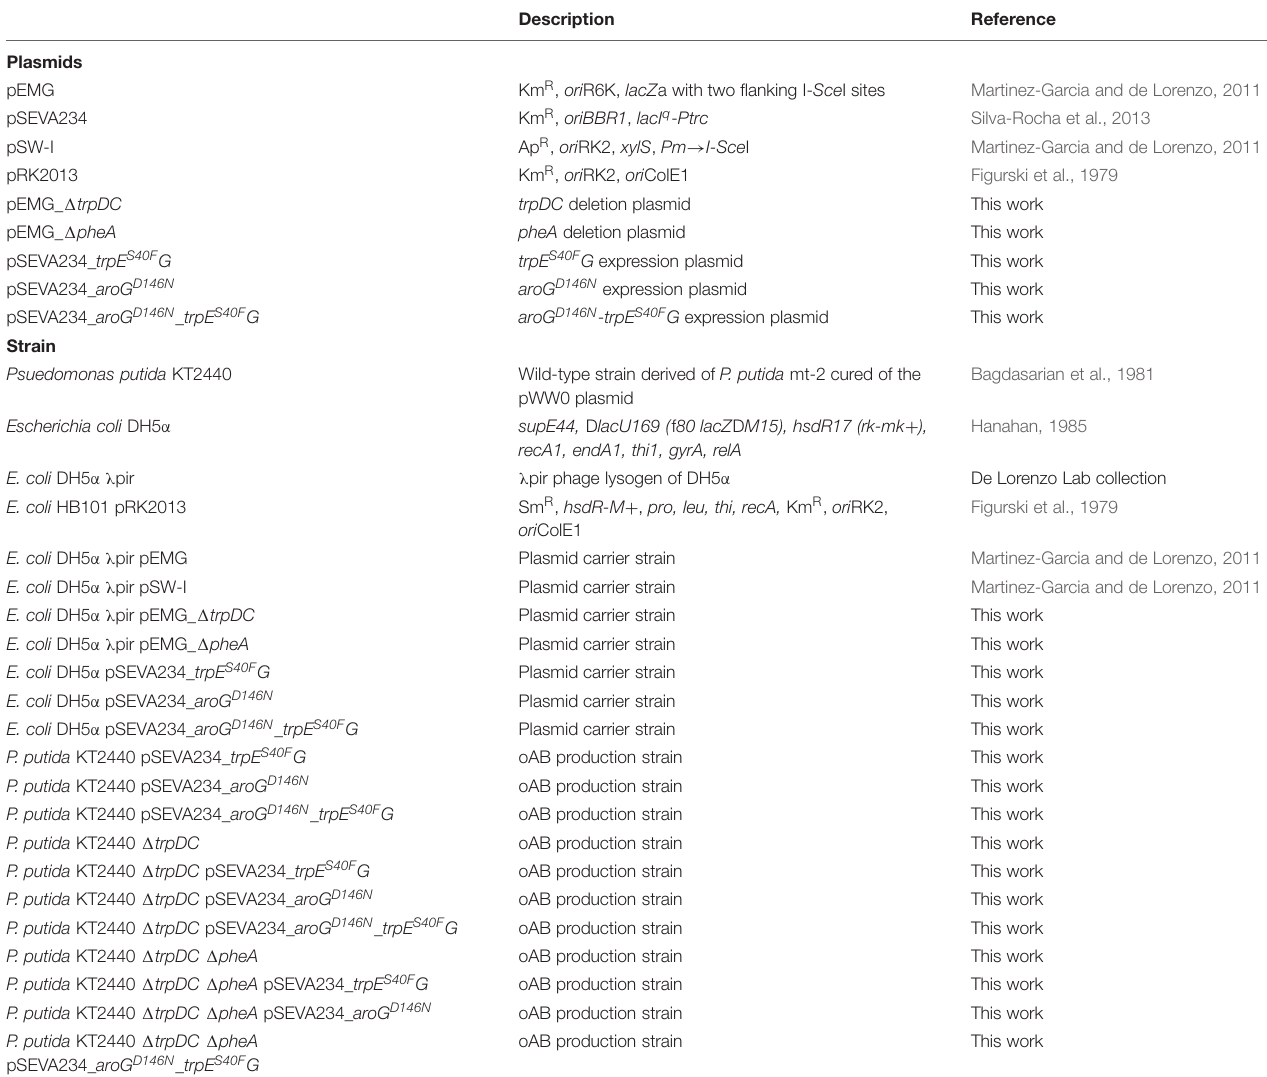
TABLE 2 | Summary of plasmids and strains used in this